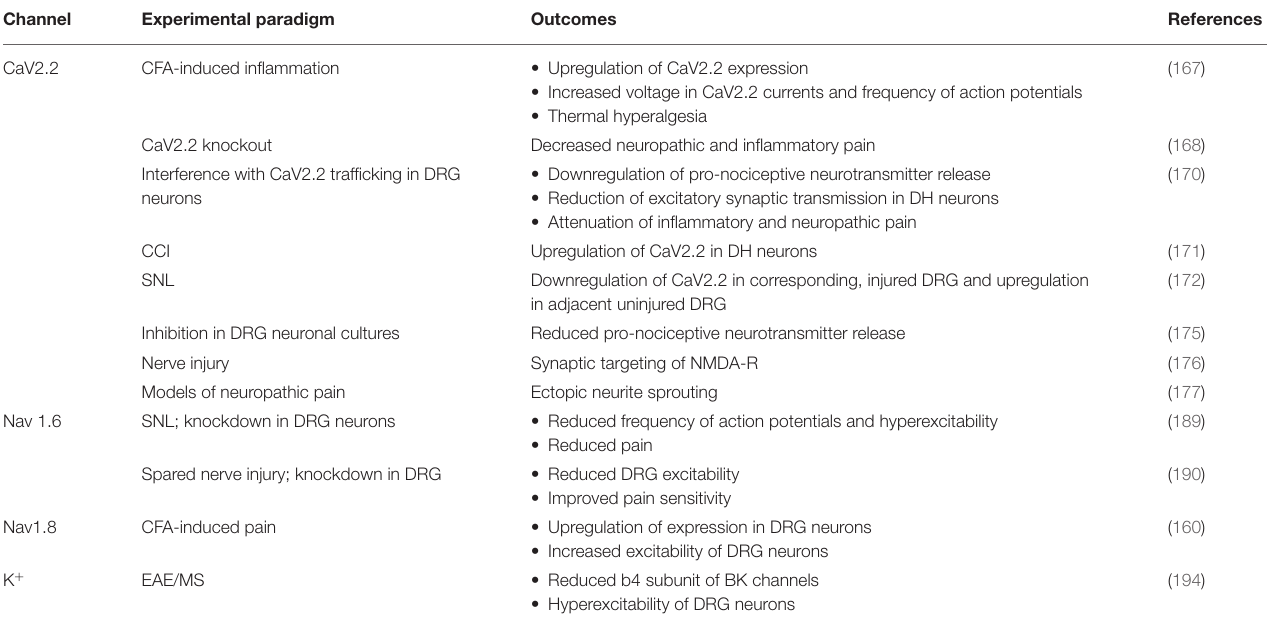
TABLE 1 | Summary of studies implicating ion channels in pain and their principal findings.